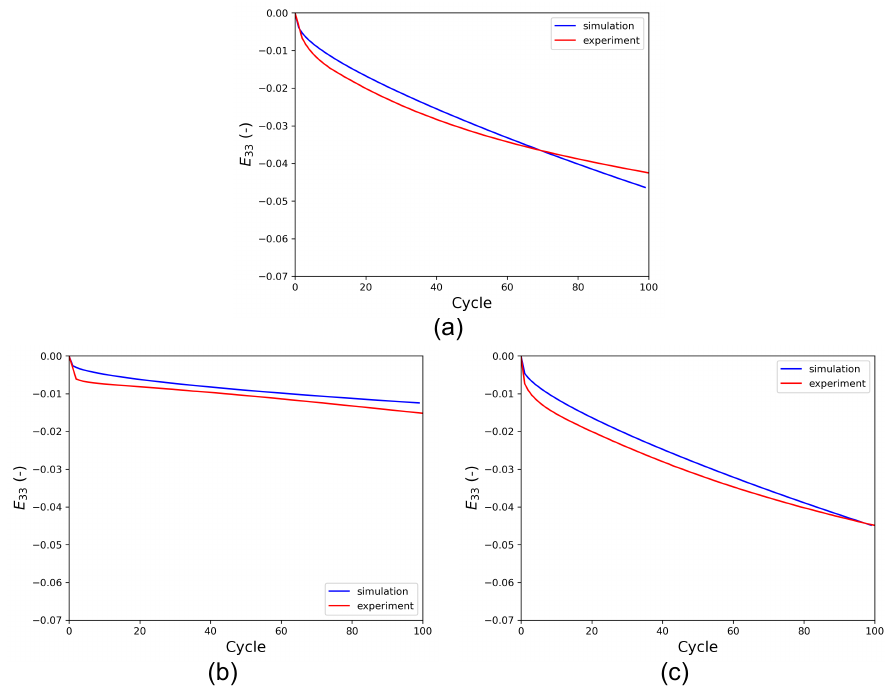
Figure 12. Axial creep strain ( E 33 ) vs. the number of cycles obtained from HPTF simulations with the CPFE model and from experiment for a constant axial pressure of σ 33 = 250 MPa and cyclic torsional loading: ( a ) R = − 1, θ = 7.5 ◦ ) used for calibration, ( b ) R = 0, θ = 10 ◦ , and ( c ) R = 0, θ = 15 ◦ . Cases ( b , c ) represent predictions of the